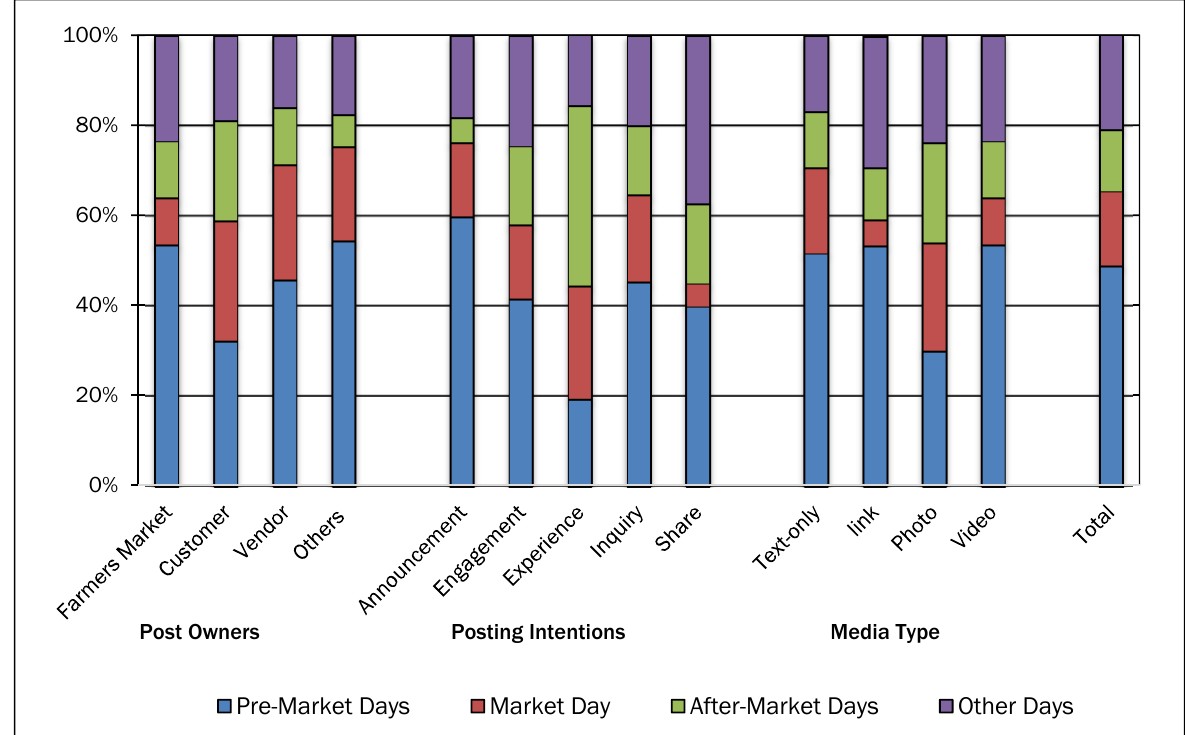
Figure 5. Distribution of Posts ( N =6,369) by Day of the Week Corresponding to Market